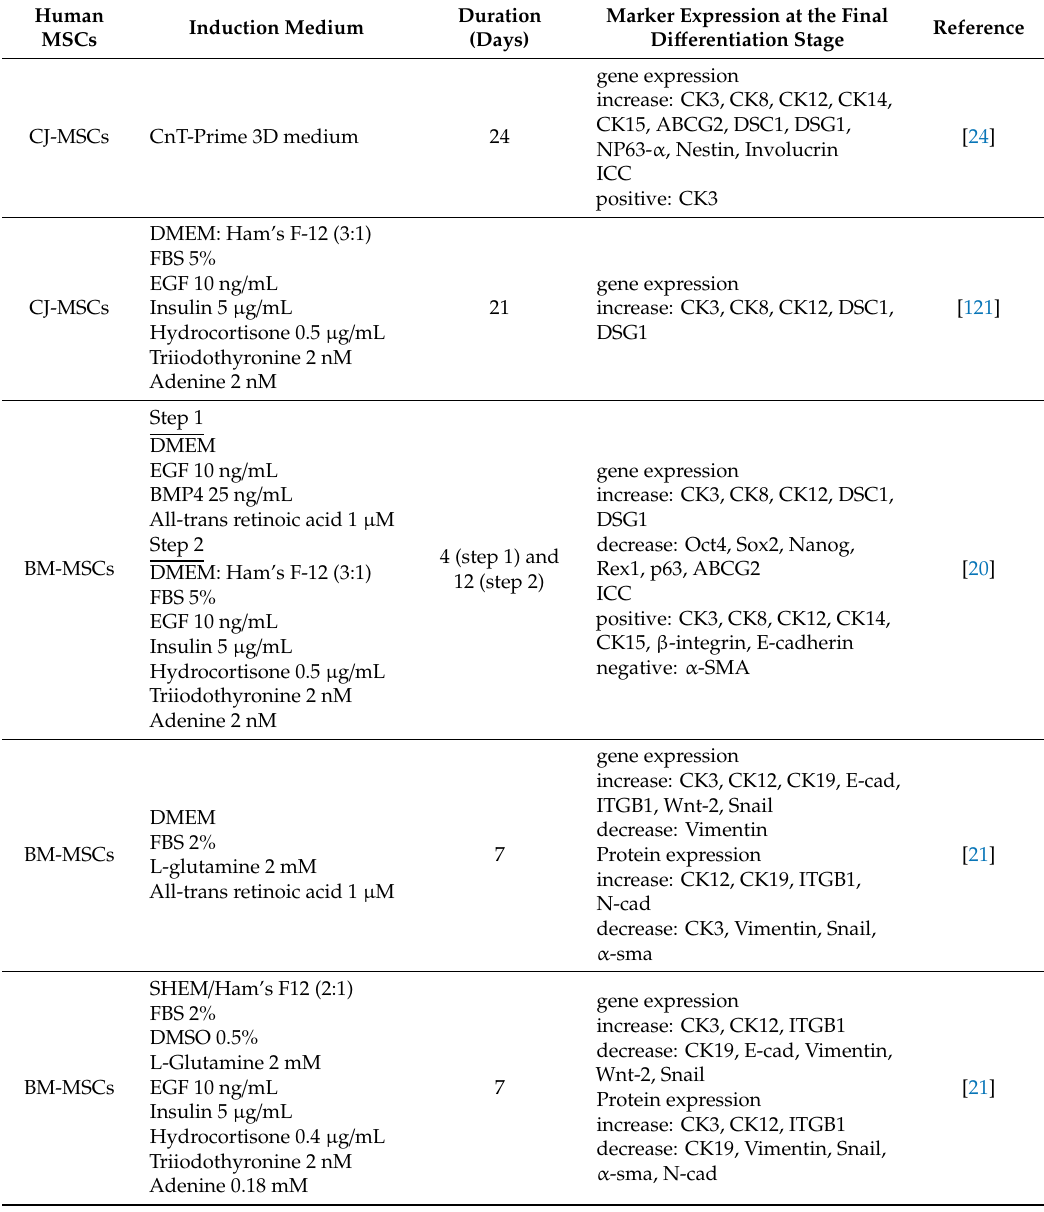
Table 2. Corneal epithelial di ff erentiation of human MSCs by defined induction